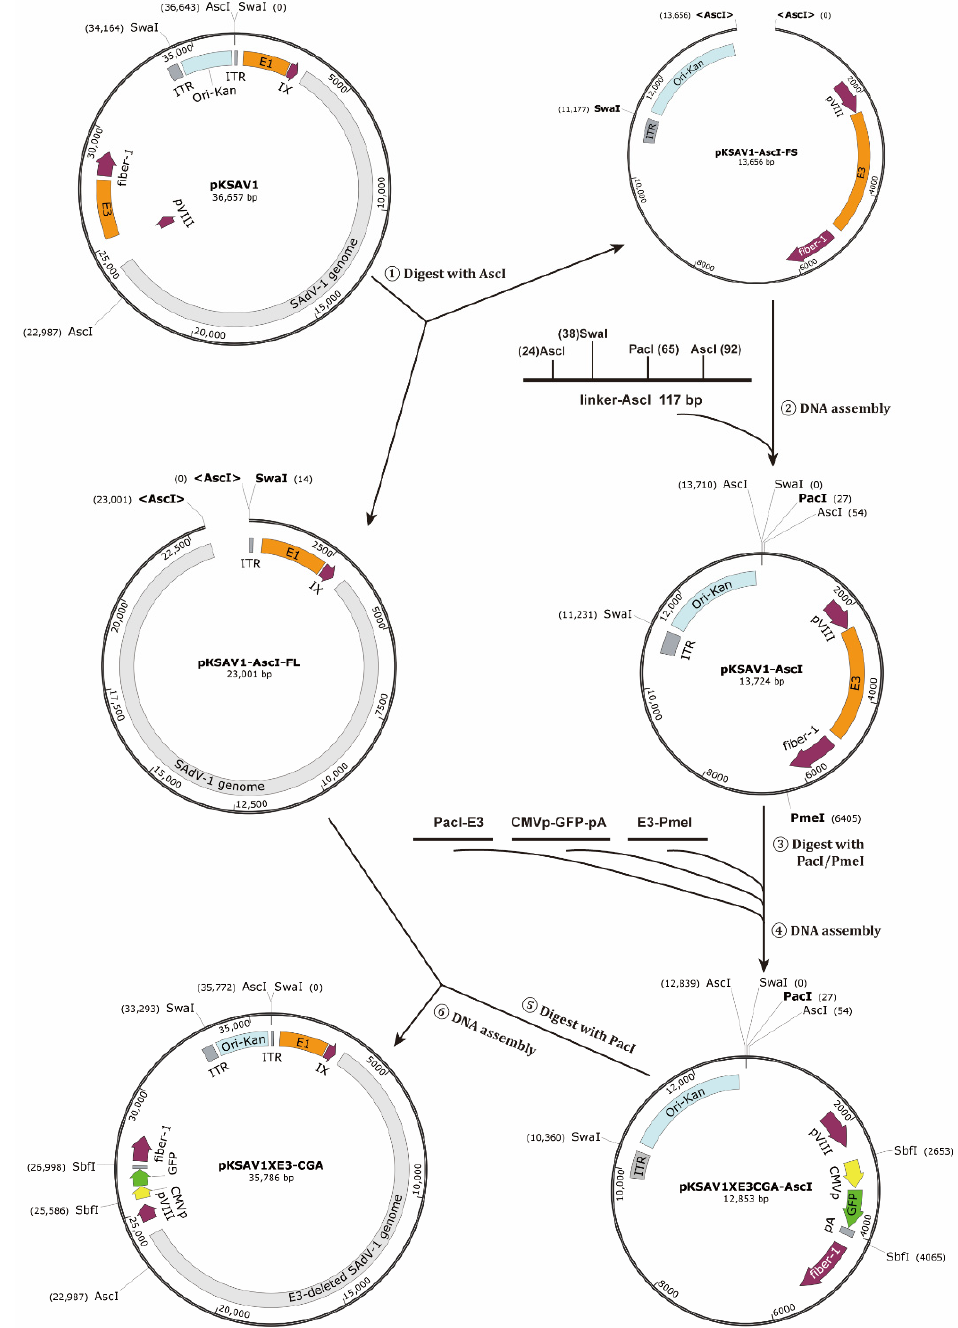
Figure 2. Schematic diagram of constructing adenoviral plasmid pKSAV1XE3-CGA.